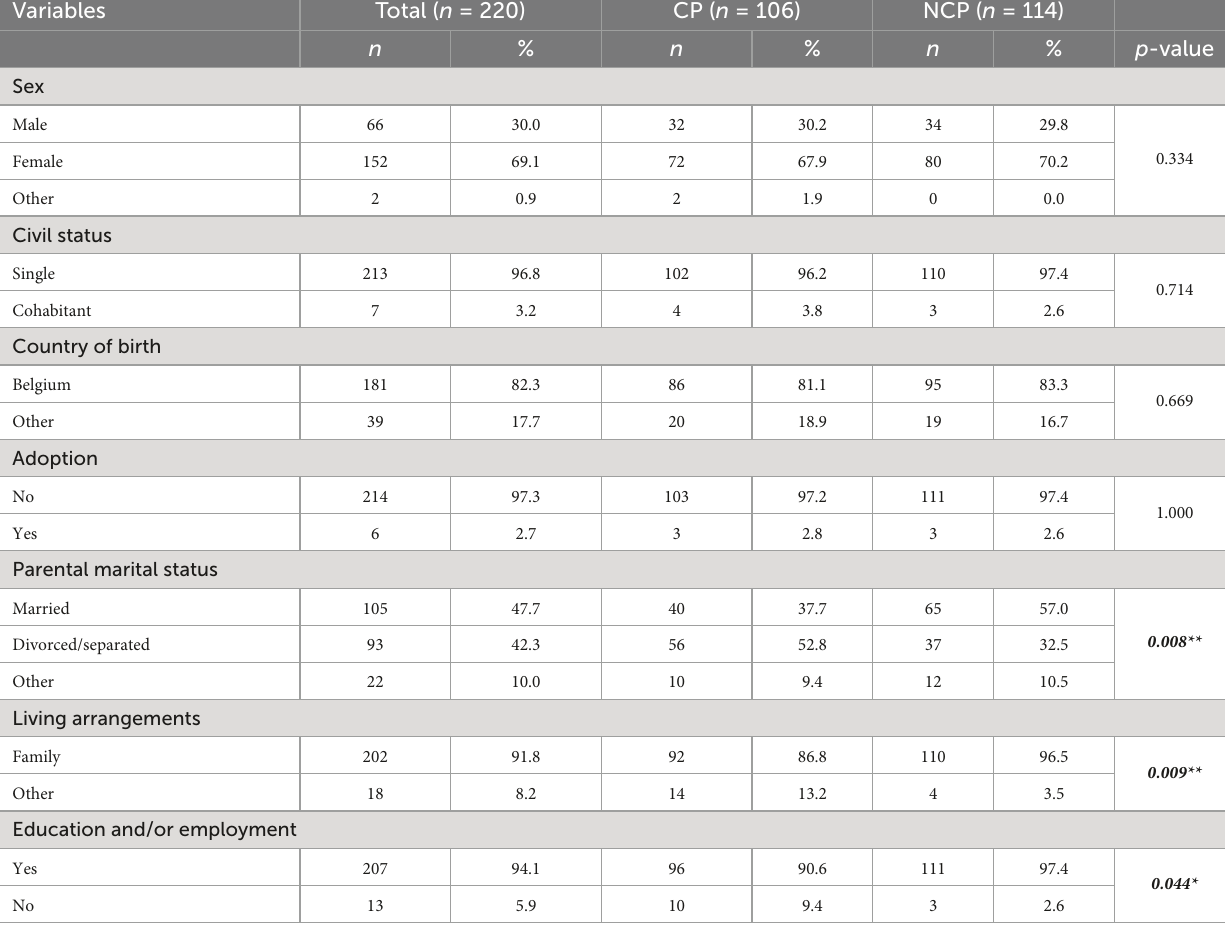
TABLE 1 Sociodemographic characteristics of the sample and comparisons of the groups ( N =